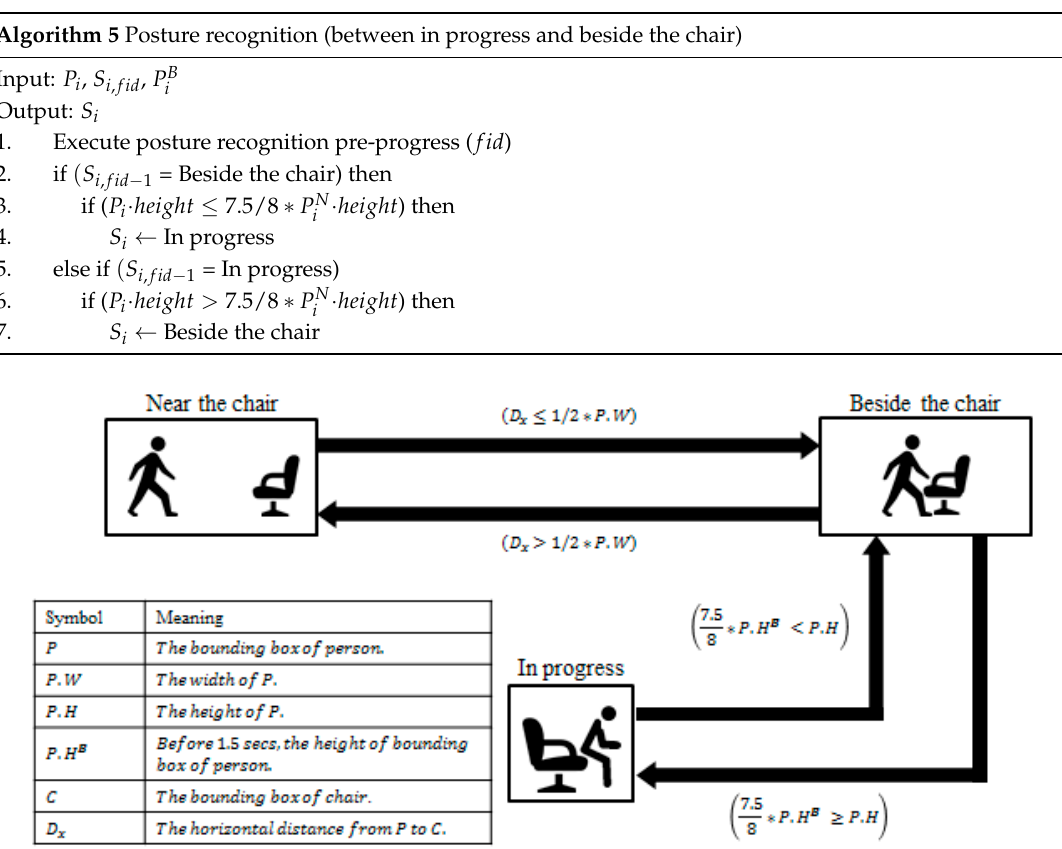
Figure 3. The flow of the state when the person is near or beside the chair.